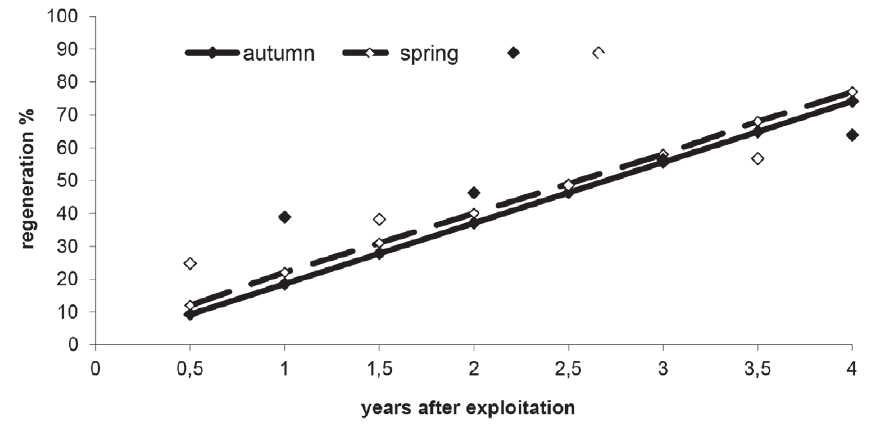
Figure 1 - Observed (dots) and estimated bark regeneration (lines) in Drimys brasiliensis in autumn and spring-time.